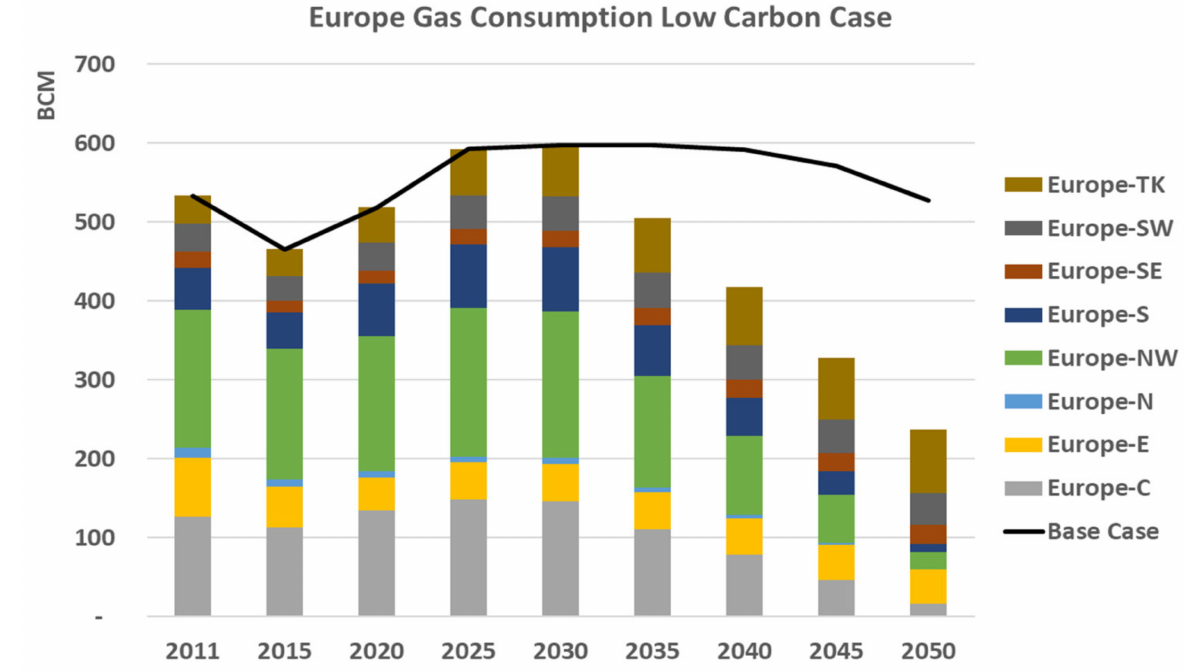
Figure 22. Europe gas consumption low-carbon case vs. base